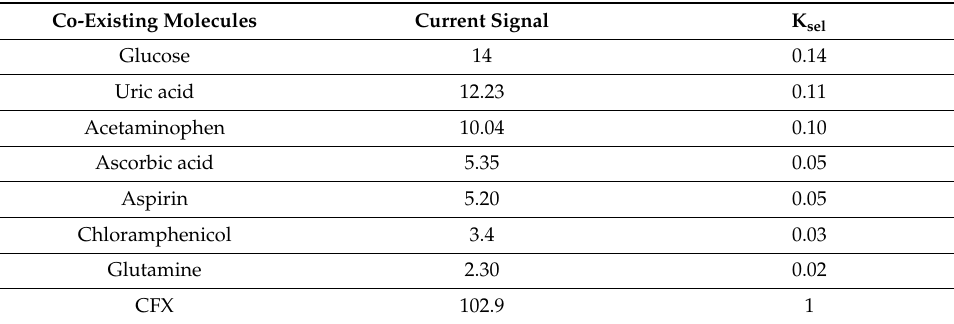
Table 2. Various interfering molecules with coefficients of selectivity ( K sel